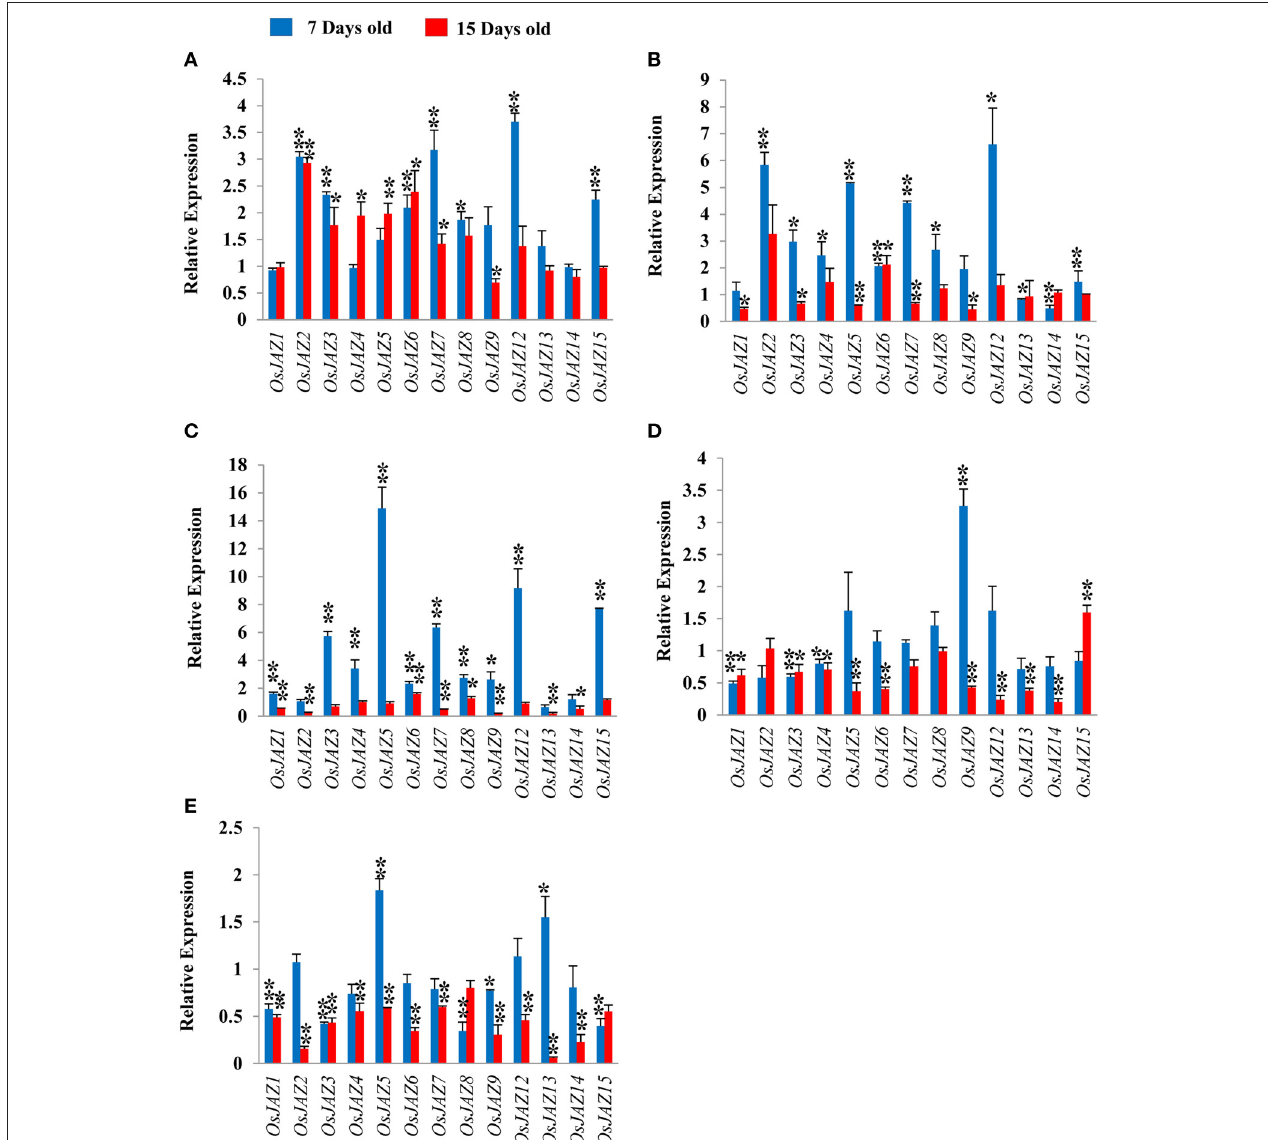
FIGURE 8 | Relative expression profile of OsJAZ genes under (A) N, (B) P, (C) K, (D) Fe, and (E) Zn deficiency after 7 (early response) and 15 days (late response) of respective stress treatment in rice root. qRT-PCR was used for quantitation of gene expression. Each bar shows the average of three biological replicates. Relative mRNA levels in treated plants were calculated using unstressed plants as control. Ubiquitin5 gene was taken as endogenous control. ( * p < 0.05 , ** p < 0.01